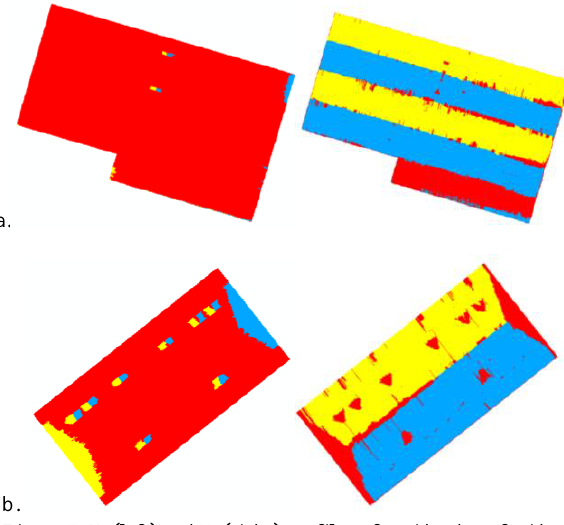
Figure 5. X (left) and Y (right) profiles of a. ridged roof with a flat section b. a hipped roof with dormer windows segmented into positive slopes (yellow), negative slopes (blue) and flat (red).